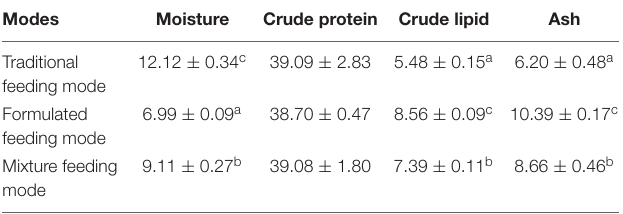
TABLE 1 | Conventional biochemical composition of different baits (% dry weight).